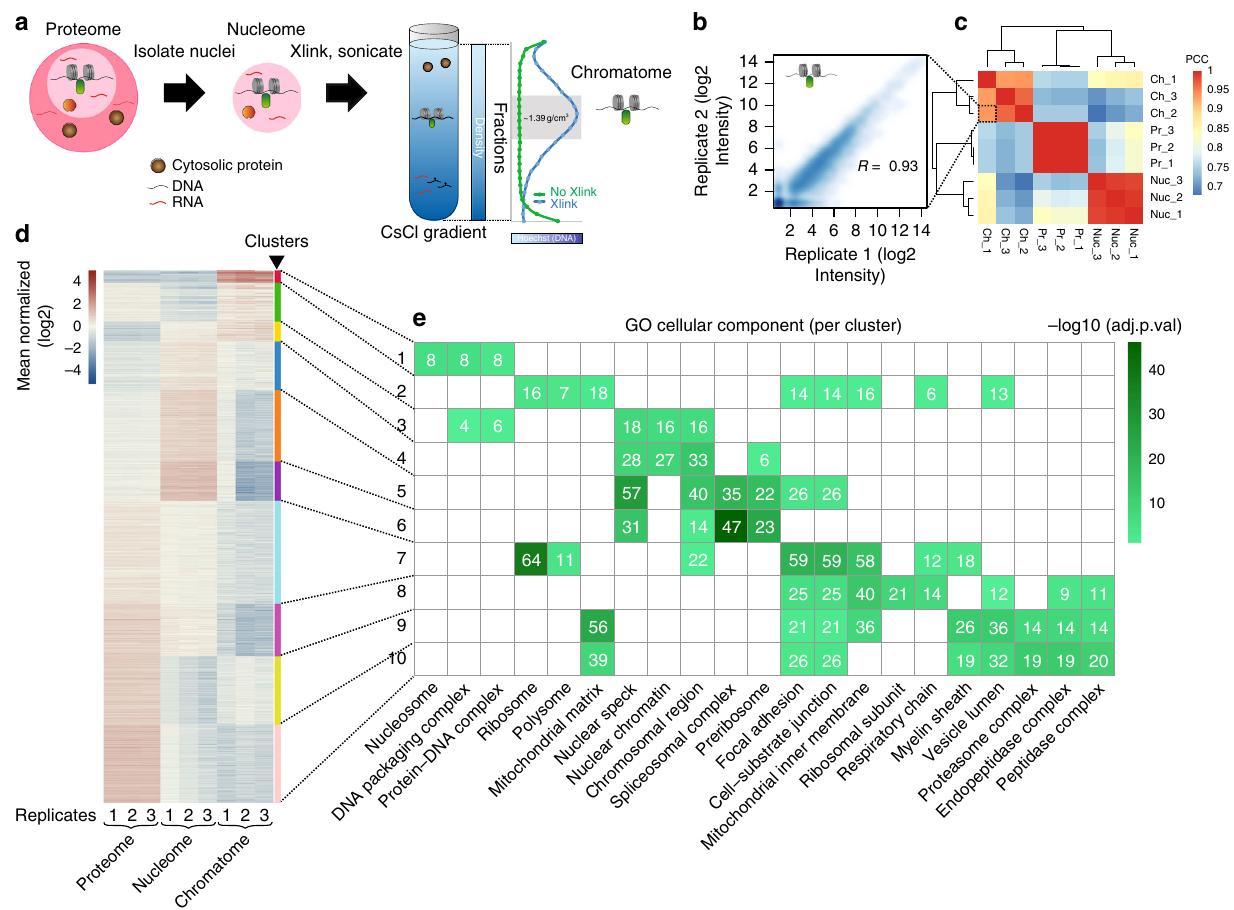
Fig. 1 Strategy to quantify chromatin-associated proteins in different cellular states. a Experimental strategy for chromatin and nuclear enrichment. The blue and green lines to the right of the gradient represent Hoechst staining ( x -axis) of different gradient fractions ( y -axis). Xlink refers to cross-linking with formaldehyde. b Reproducibility between replicates of independent chromatome preparations. c Reproducibility among normalized Chromatome (Ch), Nucleome (Nuc), and cellular Proteome (Pr) signal. Scale is similarity as Pearson ’ s R . PCC Pearson ’ s correlation coef fi cient. d Clustering of signal at the protein level across subcellular fractions and all replicates. Scale is mean-normalized log2 converted reporter intensities. Colored annotation bar represents individual clusters. e Top two cellular component ontologies for each cluster and their representation in all clusters. Terms enriched in each cluster are noted on the x -axis, clusters on the y -axis. Number of proteins belonging to a category in a particular cluster are noted in white text for the corresponding cell. Signi fi cance is − log10 (adjusted p- value). White squares represent nonsigni fi cant